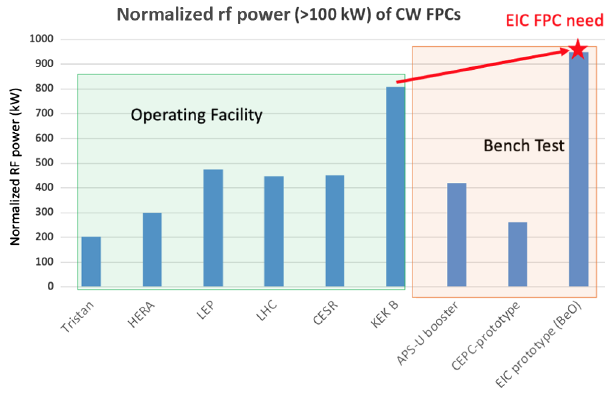
FIG. 2. High normalized power ( > 100 kW)